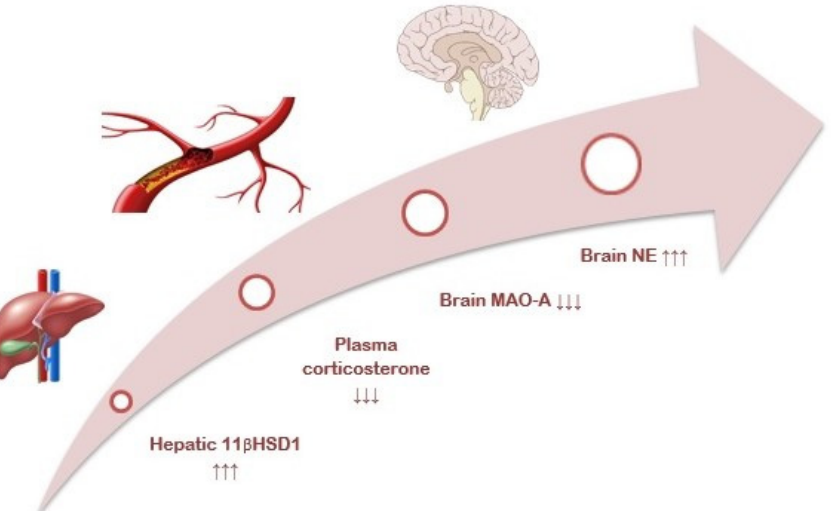
Figure 8. 11- β HSD-1-dependent pathway of anxiety-like behavior. In the post-traumatic period, activation of 11- β HSD-1 and reduction in plasma corticosterone occur. In turn, lower plasma corticosterone is associated with a reduction in brain MAO-A activity and with an increase in brain norepinephrine concentration.